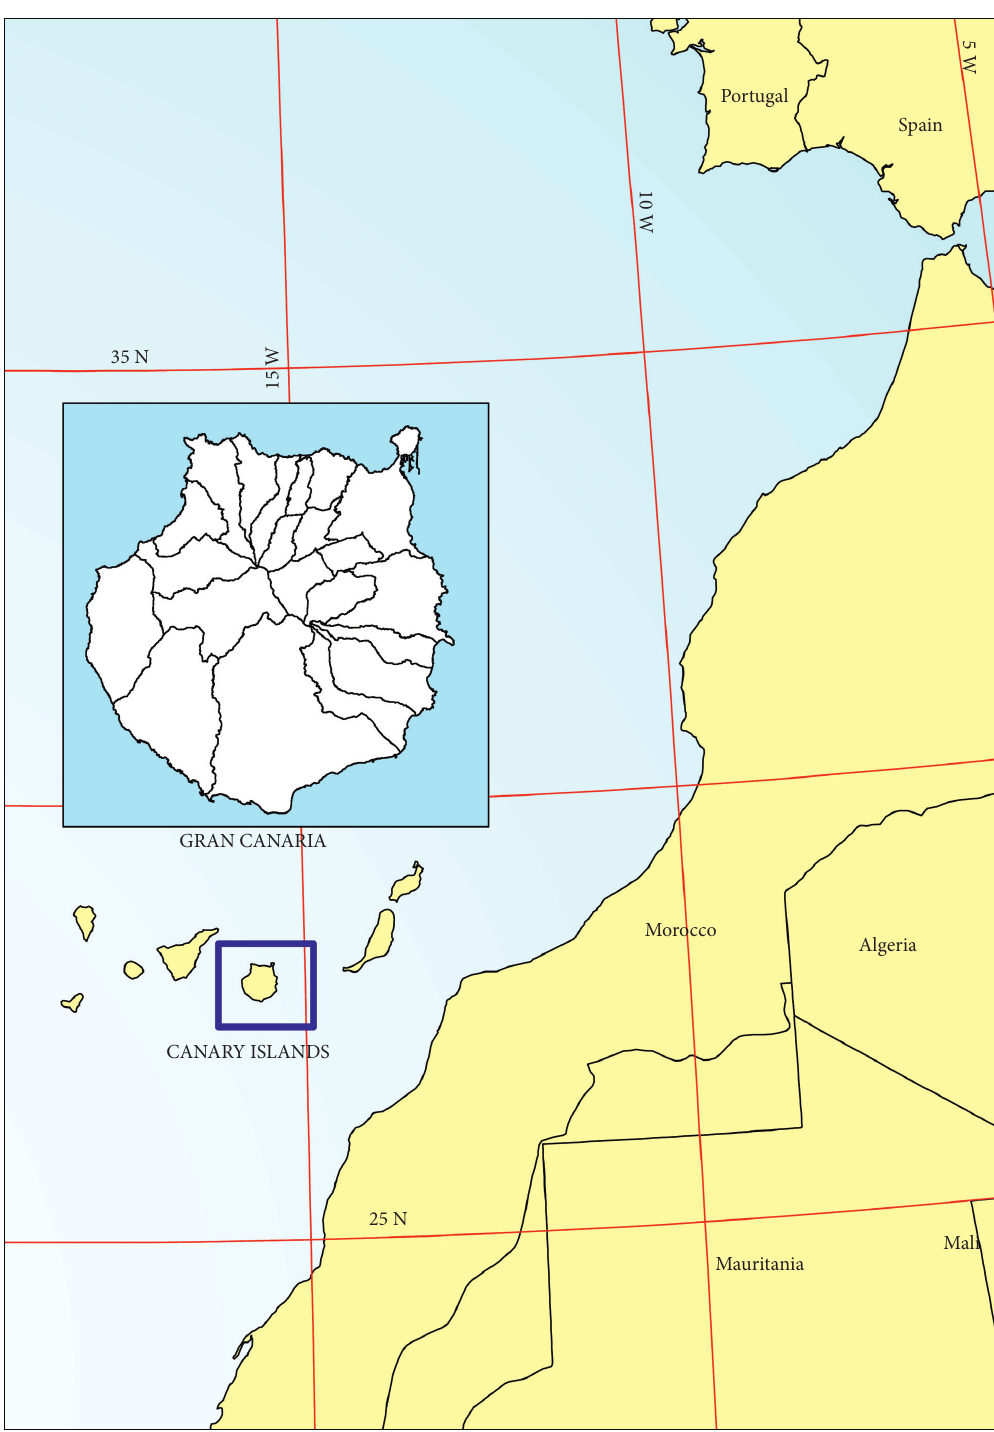
Figure 1: Geographical location of Gran Canaria